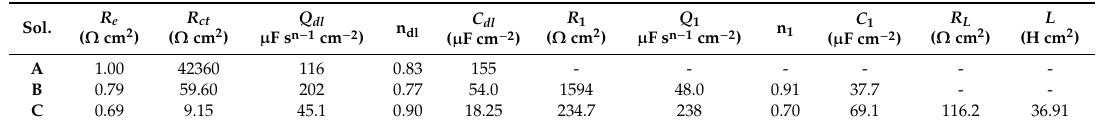
Table 6. Electrochemical impedance parameter values for the corrosion of Fe in various bromide-based